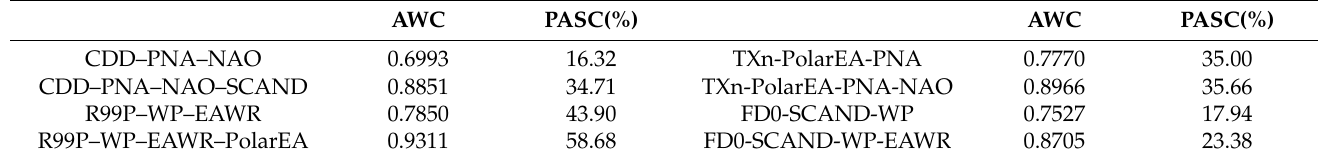
Table 6. The AWC and PASC of the multiple wavelet coherence (MWC) between extreme climate indices and teleconnection patterns in the Beijing–Tianjin–Hebei